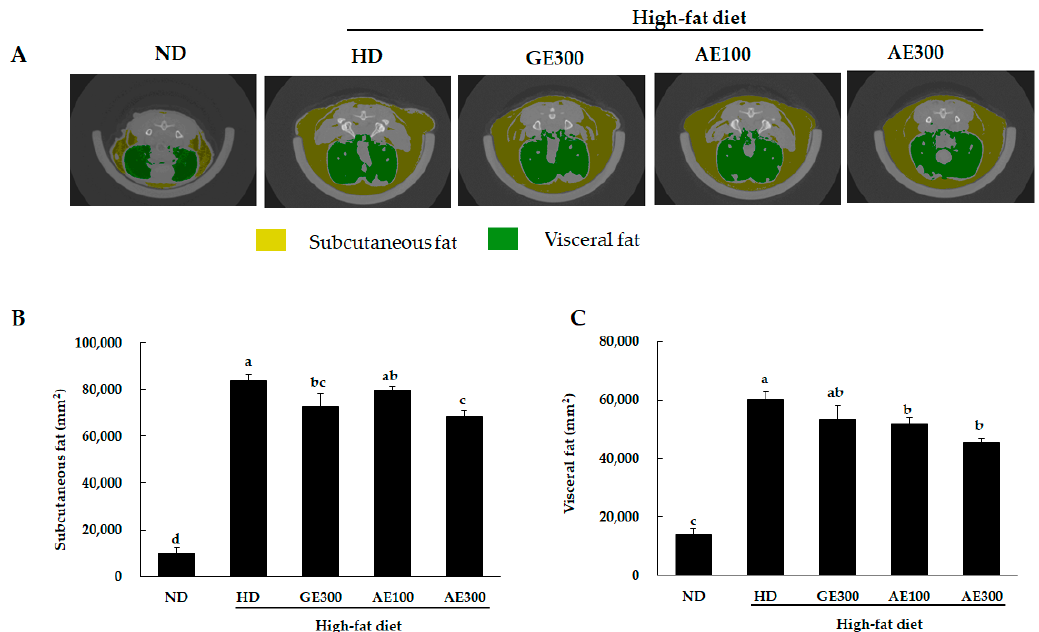
Figure 2. Effect of AE on abdominal fat volume in the experimental mice. Mice were fed a high-fat diet and orally administered a GE (300 mg/kg b.w) or an AE (leaf extract) at low dose (100 mg/kg b.w) or high dose (300 mg/kg b.w) for 8 weeks. ( A ) Micro-CT image of the abdomen region, ( B ) subcutaneous fat volume, and ( C ) visceral fat volume. ND, normal diet, HD, high-fat diet, GE300, high-fat diet + Garcinia 300 mg/kg b.w, AE100, high-fat diet + 100 mg/kg b.w, AE300, high-fat diet + 300 mg/kg b.w. Values are expressed as mean ± SEM, n = 5. The varying superscript letters indicate a statistically significant difference among the groups by Duncan’s test of ANOVA, p < 0.05.